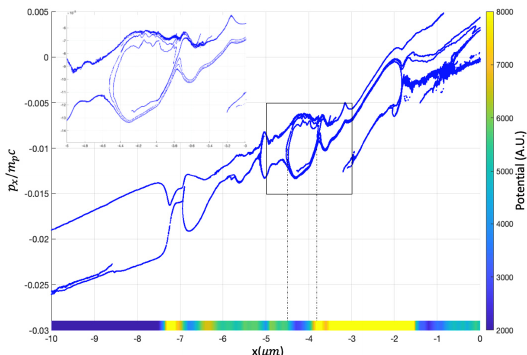
Figure 6. Plot of the proton phase space and electrostatic potential shown as a color plot on the bottom at 1700 fs. The potential displays a dip in the region where protons are trapped. The trapped region magnified in the inset.